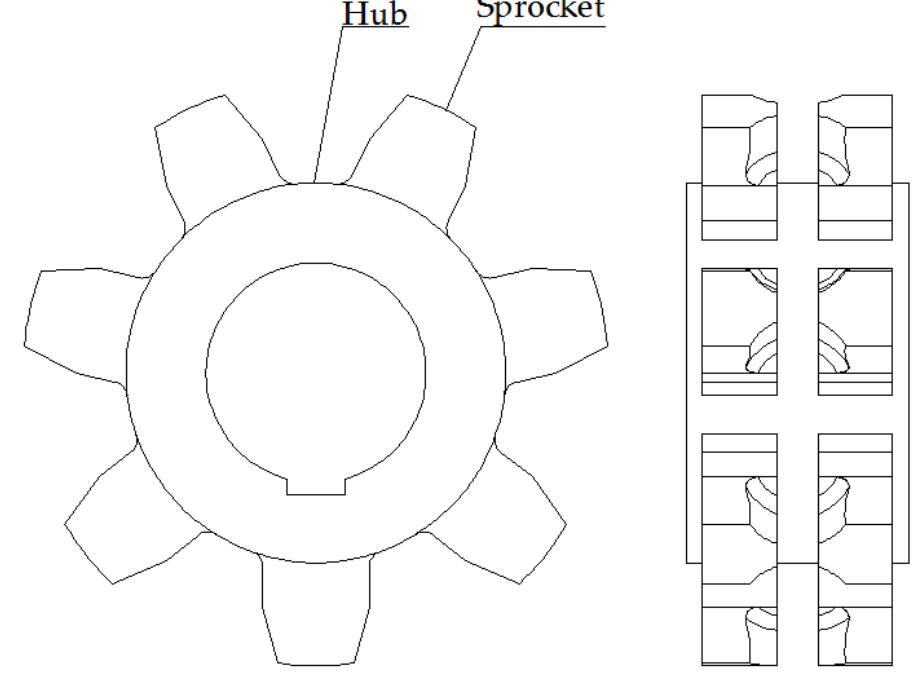
Figure 1. Structure diagram of scraper conveyor sprocket.